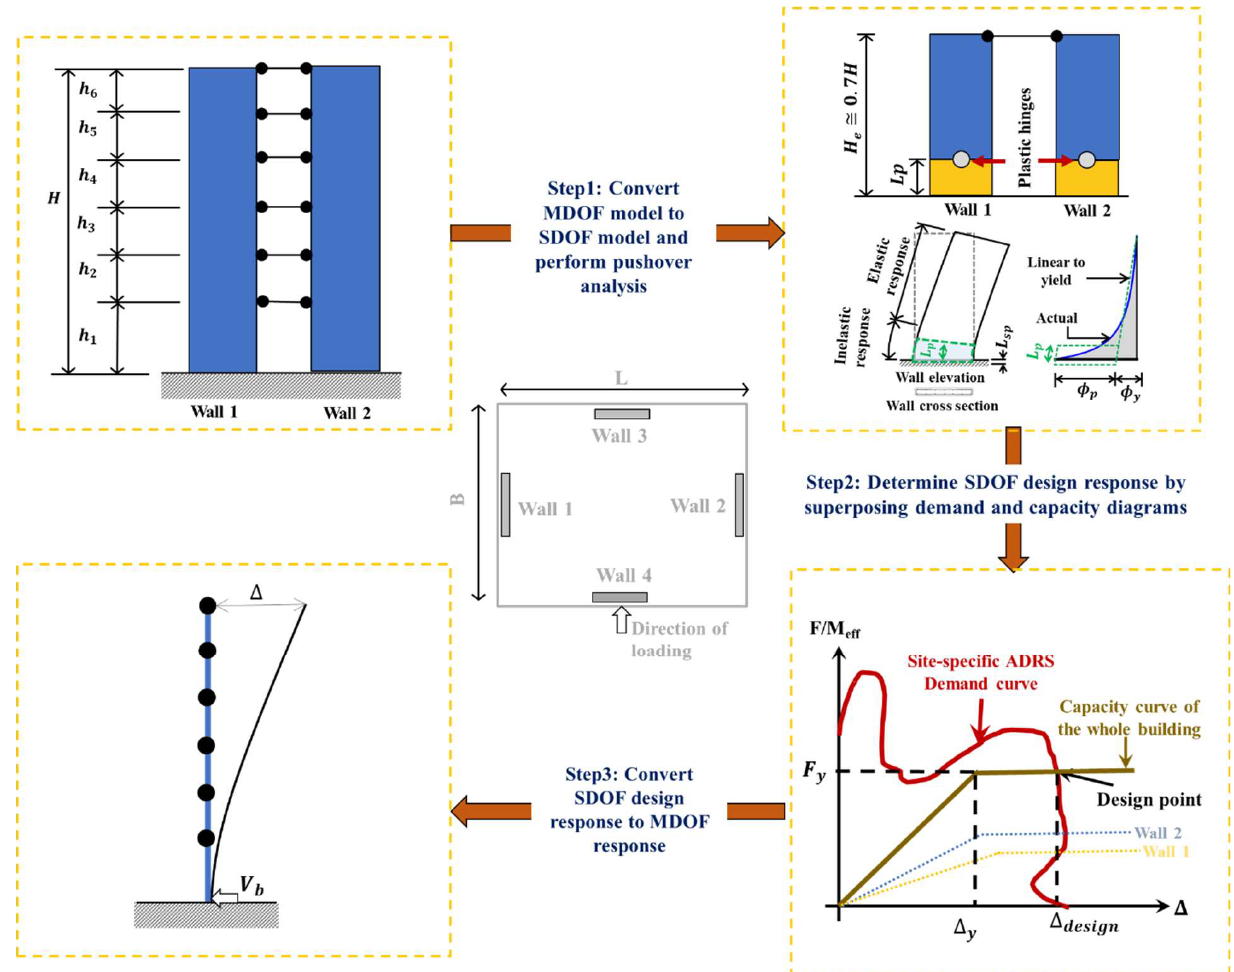
Figure 9. Proposed nonlinear analysis procedure.